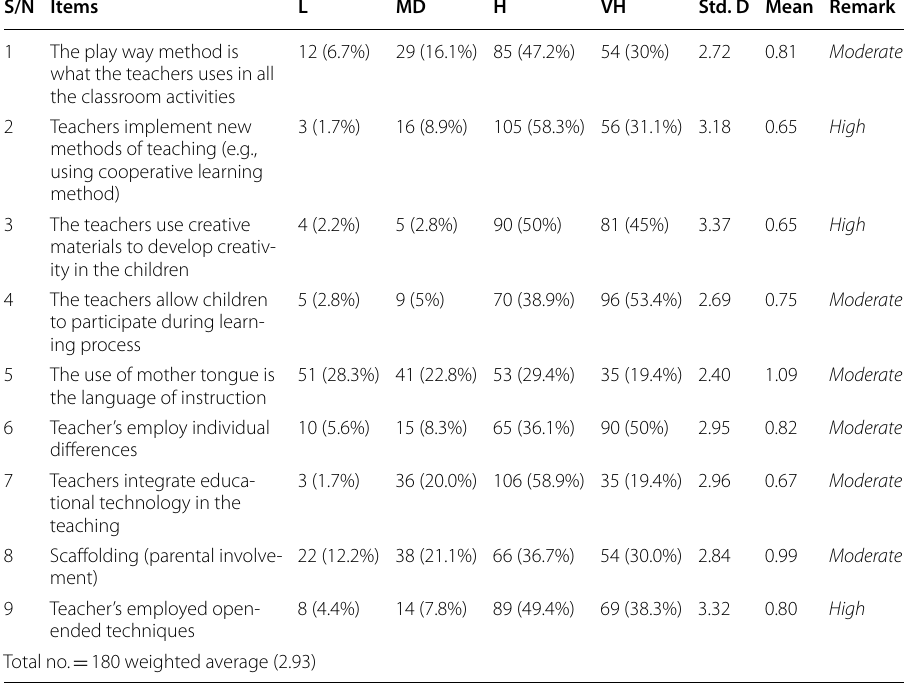
Table 2 Percentage distribution of teaching strategies that teachers employed. Source: Research